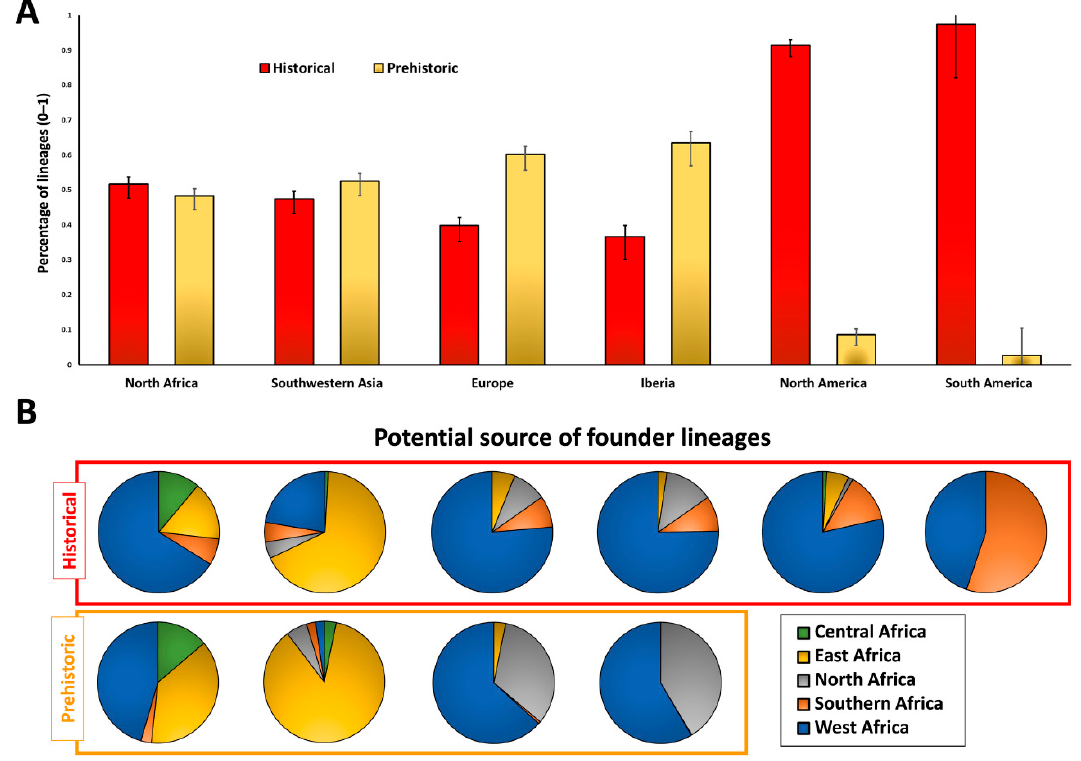
Figure 2. Founder analysis using a two-migration model for North Africa, Southwest Asia, Europe, Iberia, North America, and South America ( A ) and phylogeographic analysis of the most likely source of lineages for each migration ( B ).